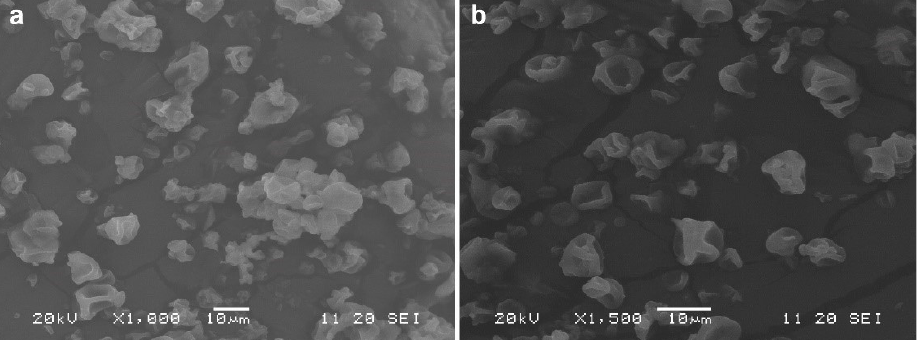
Figure 2. SEM micrographs of spray-dried A. muciniphila , encapsulated within a matrix containing 10% skim milk, using selected drying conditions (inlet/outlet temperatures: 150/65 °C); ( a ) scale bar 10 µm, magnification 1000×; ( b ) scale bar 10 µm, magnification 1500×.